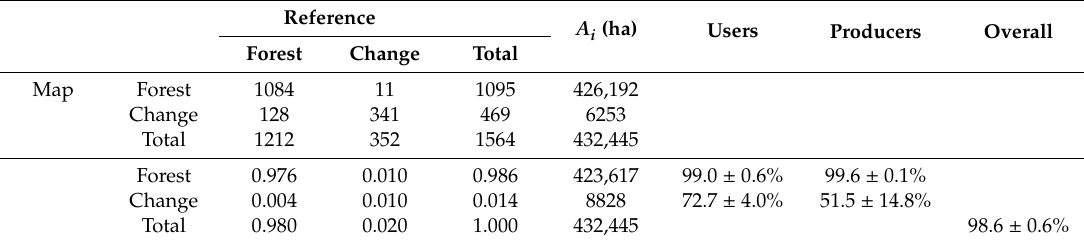
Table 6. Error matrix for Austria, blind approach.